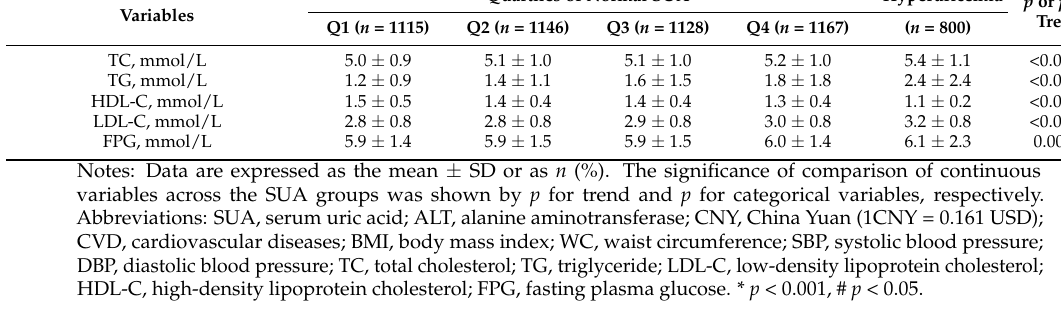
Table 2. Characteristics of subjects according to serum uric acid level in women ( n = 6216).